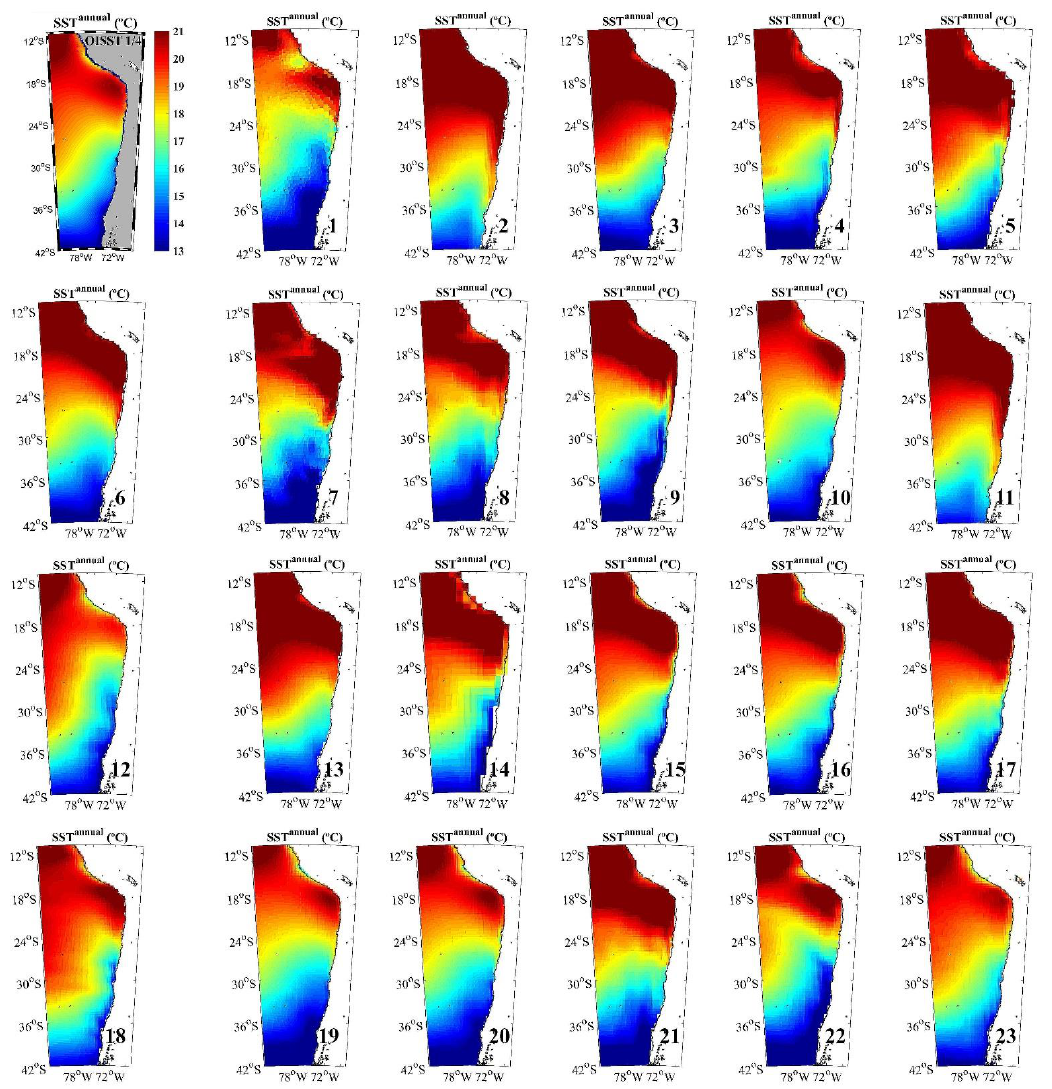
Figure 6. Mean of the annual SST (°C) for the Humboldt upwelling system from 1982 to 2014. The numbers of each map refer to Table 1. As in the case of the CUS, almost all CMIP6 GCMs are able to reproduce the OISST ¼ values within the margin of error for both the coast and the ocean (Figure 7a, b), with a slight overestimation. Only CMCC-HR4 (historical and hist-1950) (2 and 11), HadGEM- MM (6), and ICON-LR (7) clearly overestimate the coastal SST with respect to OISST¼ by more than 2 °C.